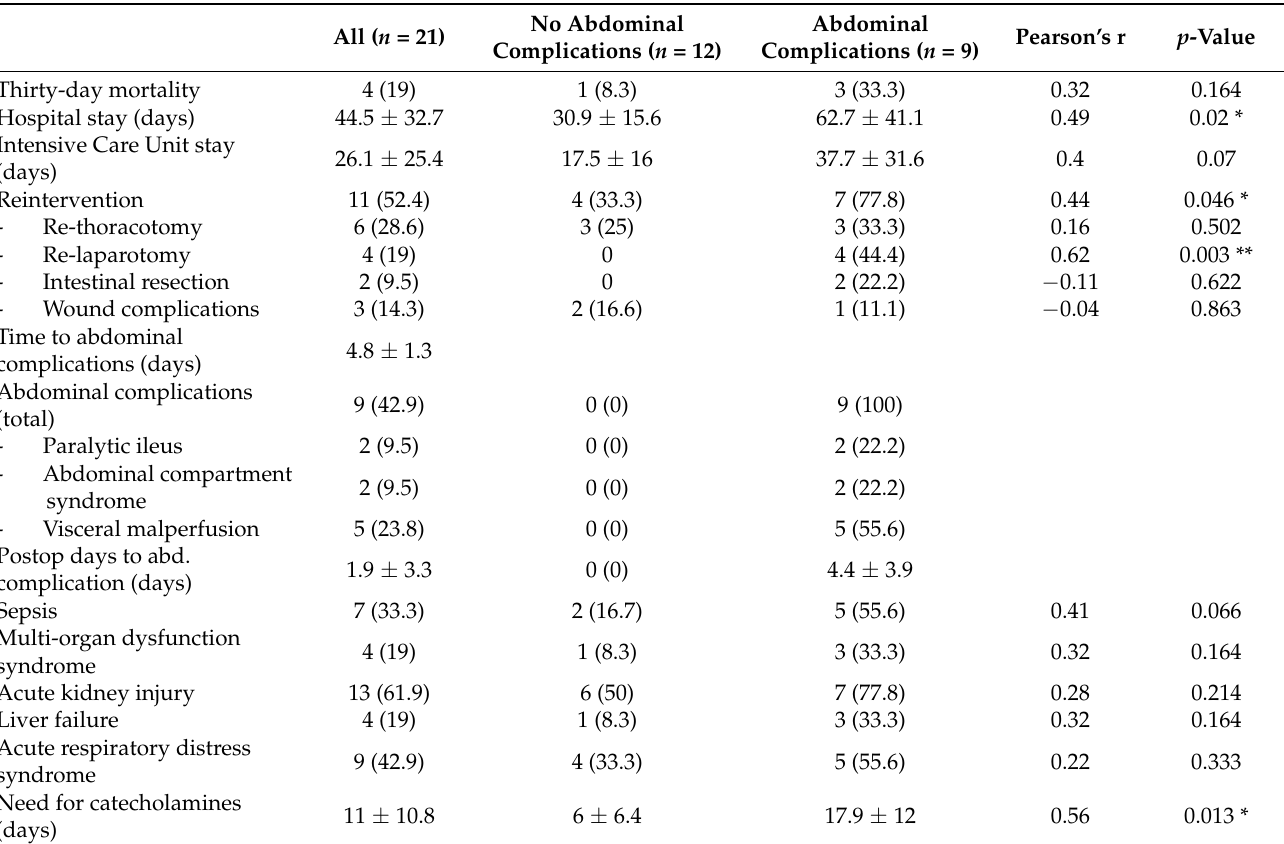
Table 2. Postoperative data. Values are the number (%) or mean ± SD, as indicated. Correlations are reported with Pearson’s (r). Significance is marked with (*) for p < 0.05 and (**) for p < 0.01. No Abdominal Abdominal All ( n = 21) Complications ( n = 12) Complications ( n =